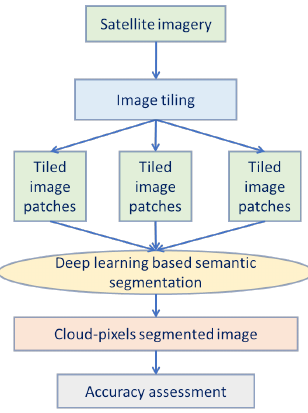
Figure 2. Simplified block diagram of the study.